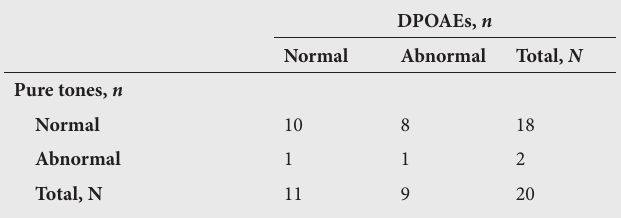
Table 6. Cross classifi cation of pure tone thresholds and DPOAEs for stage 5 participants for 4 000 Hz/